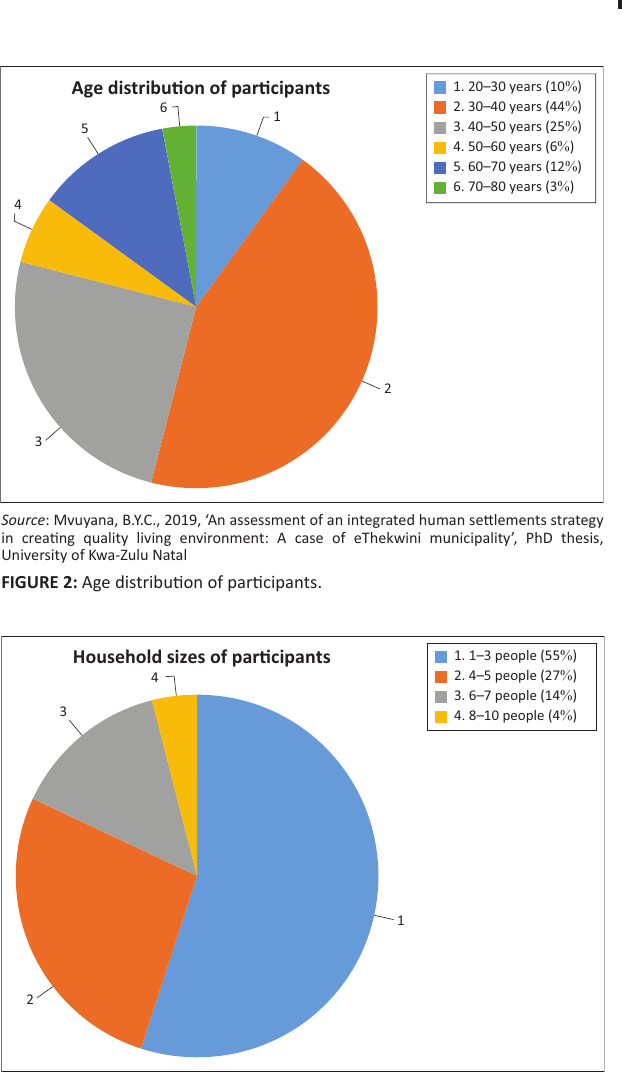
FIGURE 3: Household sizes of